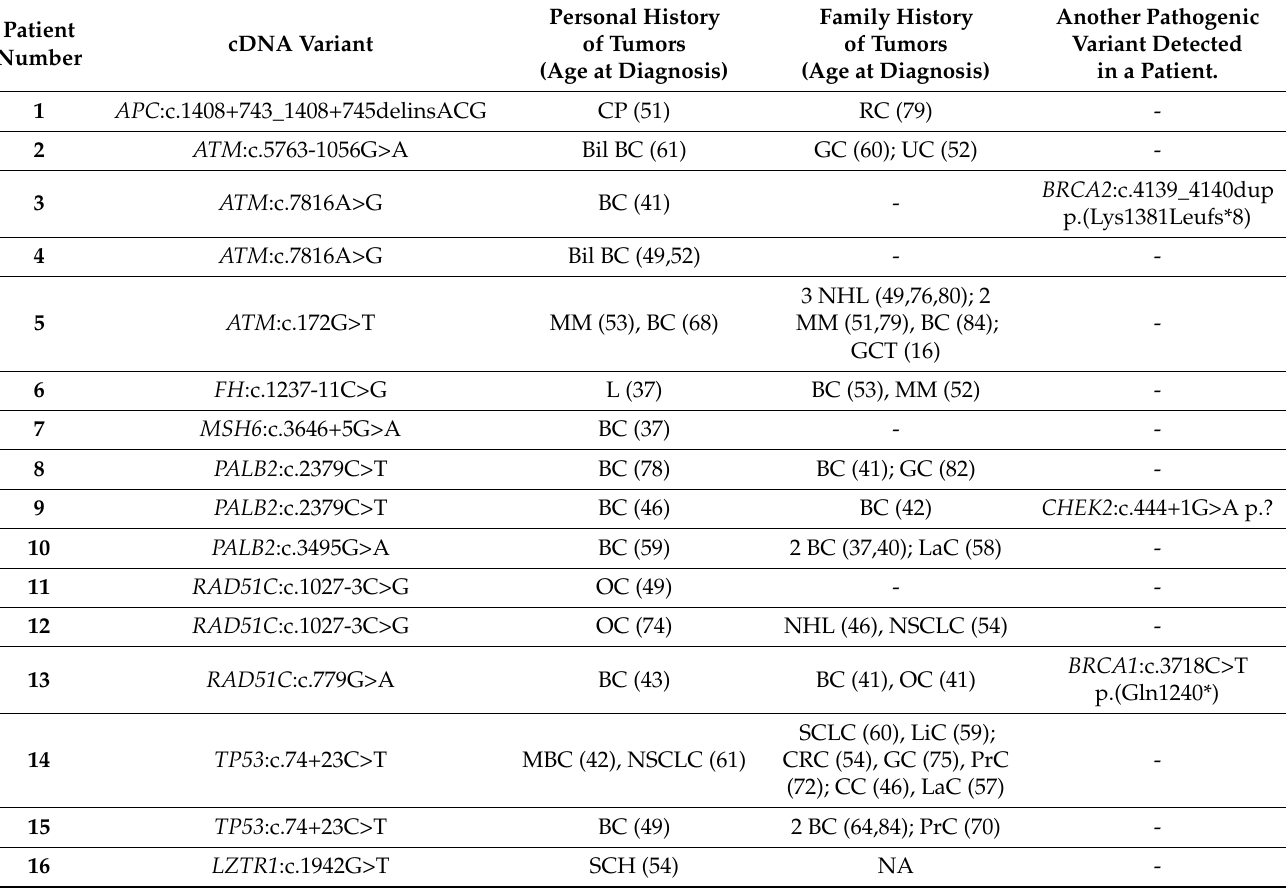
Table 2. Personal and family history of cancer in patients that have undergone mRNA